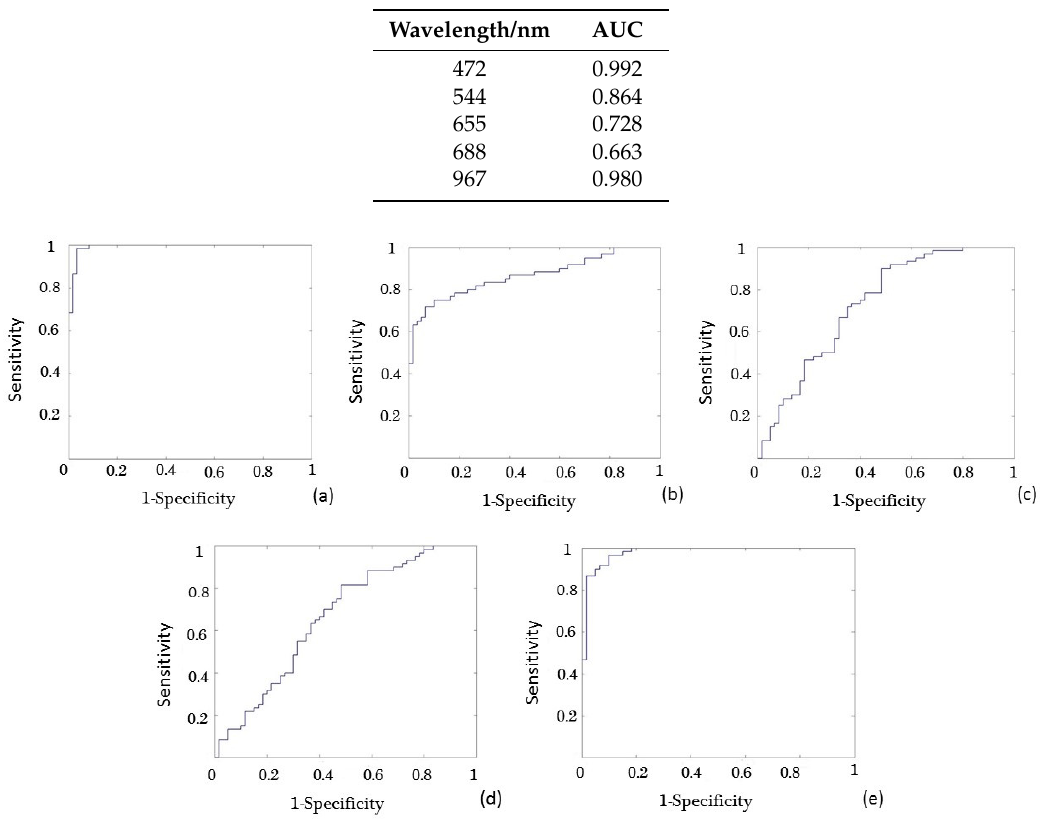
Table 1. The area under the curve (AUC) of different wavelengths by the receiver operating characteristic (ROC) curve analysis.